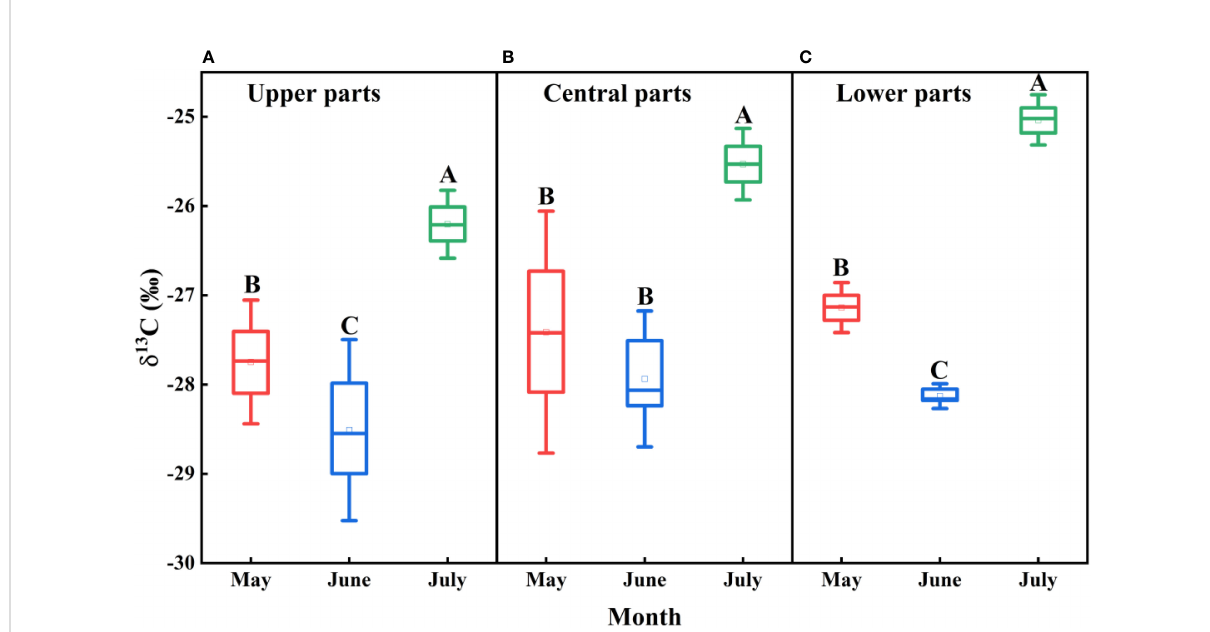
FIGURE 9 Spatio-temporal variations in d13C values for Ferula bungeana growing on mega-dunes in the Badain Jaran Desert during the 2020 growth season. (A – C) present data for the upper, central, and lower parts of mega-dunes, respectively. Data are presented as the means ± 2SD. Different uppercase letters indicate signi fi cant differences in d13C values among months at the P< 0.05 level of signi fi